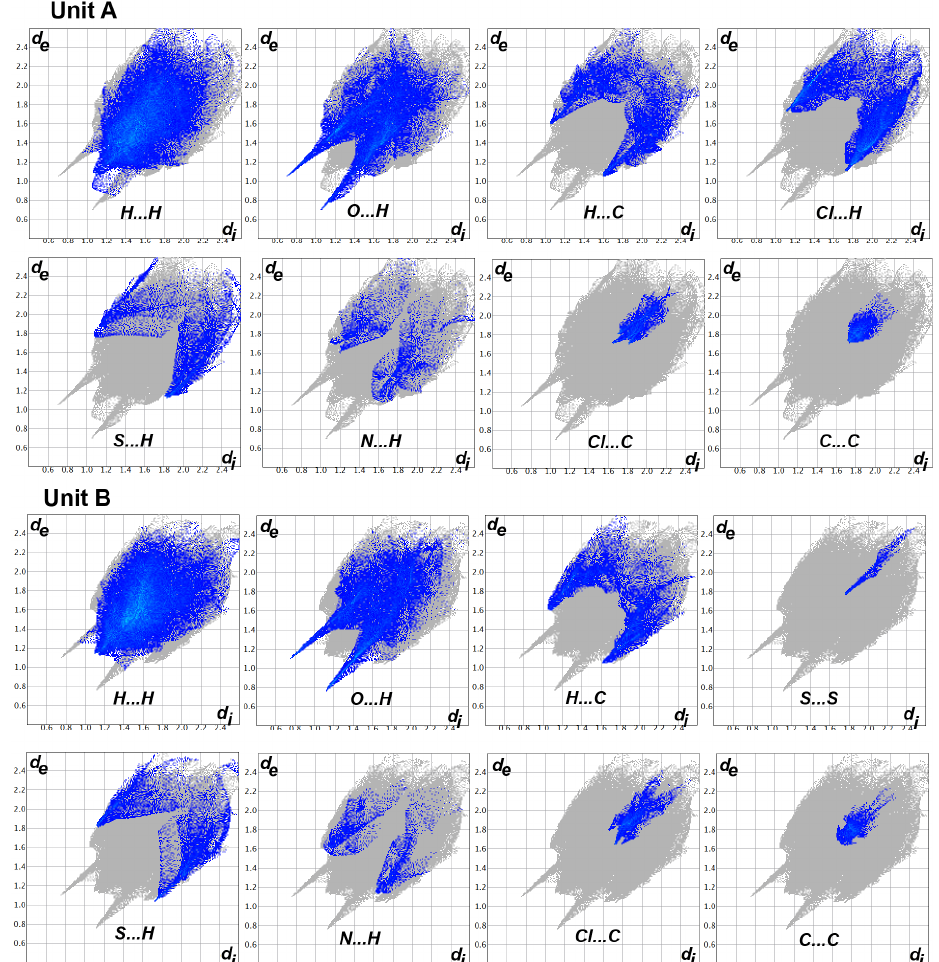
Figure 4. Decomposed fingerprint plots of the most dominant contacts of 5a .